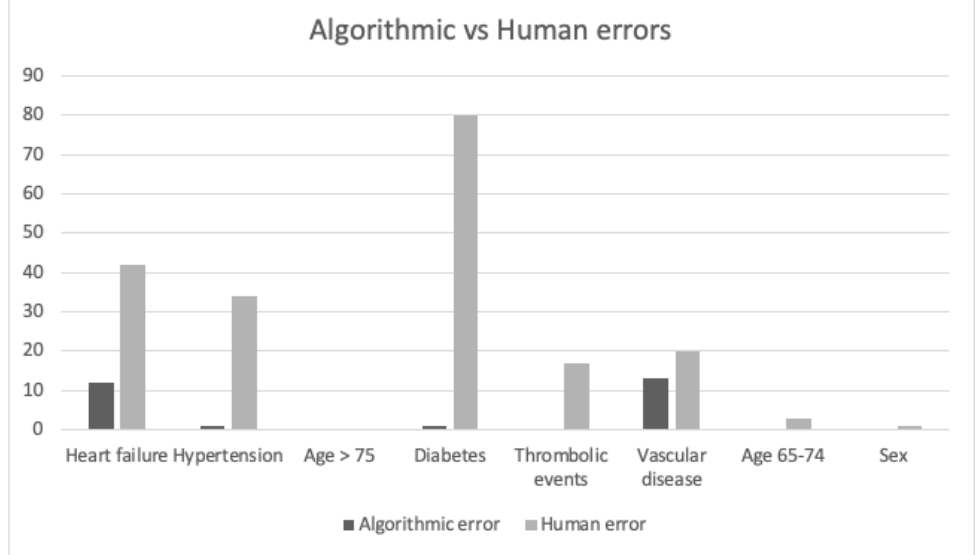
Figure 3. Bland-Altman scatter plot. Mean: mean of the different outcomes of CHA 2 DS 2 -VASc score either aCDSS or mCDSS. Diff: absolute difference in 1 patient between CCDSS and manually calculation.